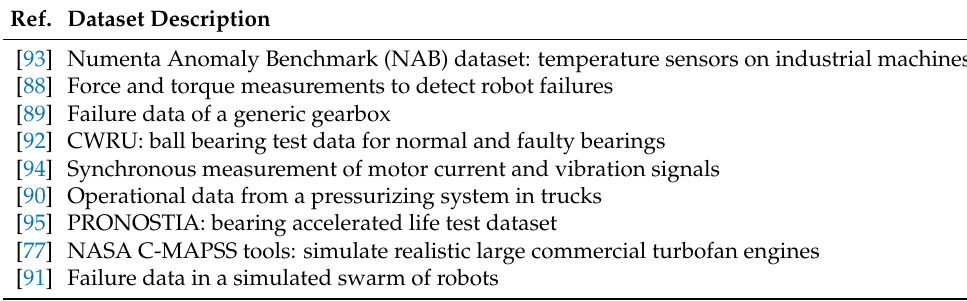
Table 2. List of datasets publicly available for PdM